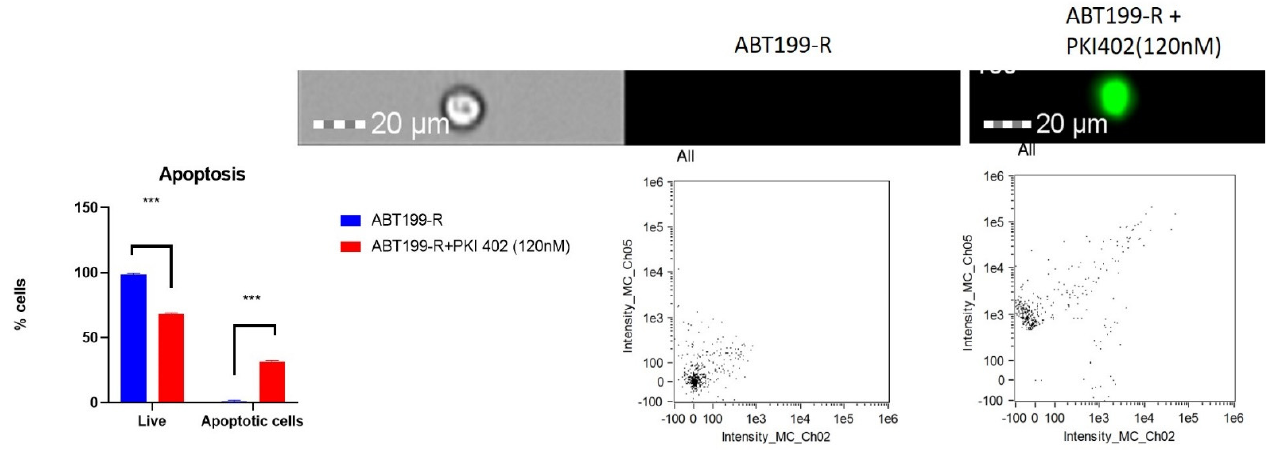
Figure 9. Inhibition of PI3K-AKT induces apoptosis in resistant ABT199-R cells: ABT199-R cells were treated with the IC50 value of PKI-402 for 48 h and stained for an Annexin-V/PI assay. The single-cell images were captured using Amnis ® FlowSight ® . The percentage of apoptosis was calculated based on cell positivity. The channel Ch05 scans for red, and Ch02 scans for green. *** p < 0.001